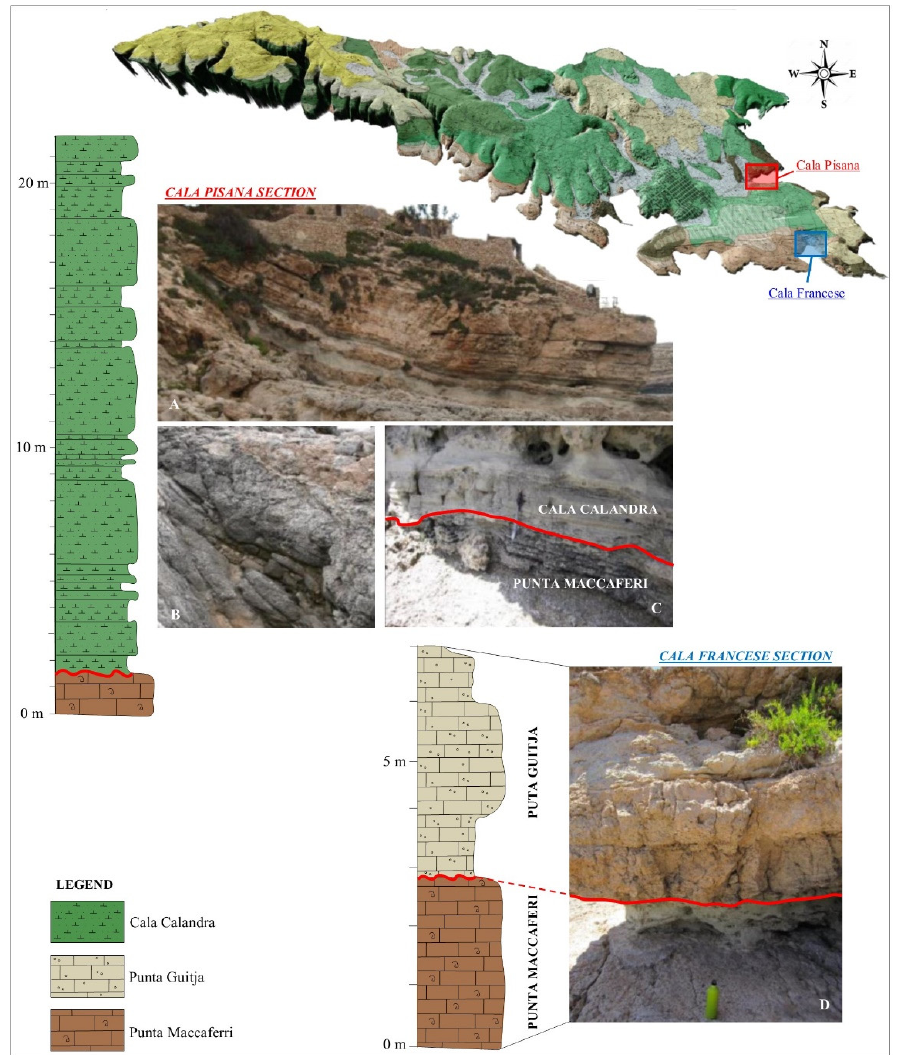
Figure 4. Lithologic log of the Cala Pisana and Cala Francese sections. ( A ) Panoramic view of the Cala Pisana outcrop. ( B ) Punta Maccaferri Beds. ( C ) Detailed view of the sharp contact between the Punta Maccaferri and Cala Calandra Beds. ( D ) Detailed view of the Punta Maccaferri Beds–Punta Guitja Beds transition.